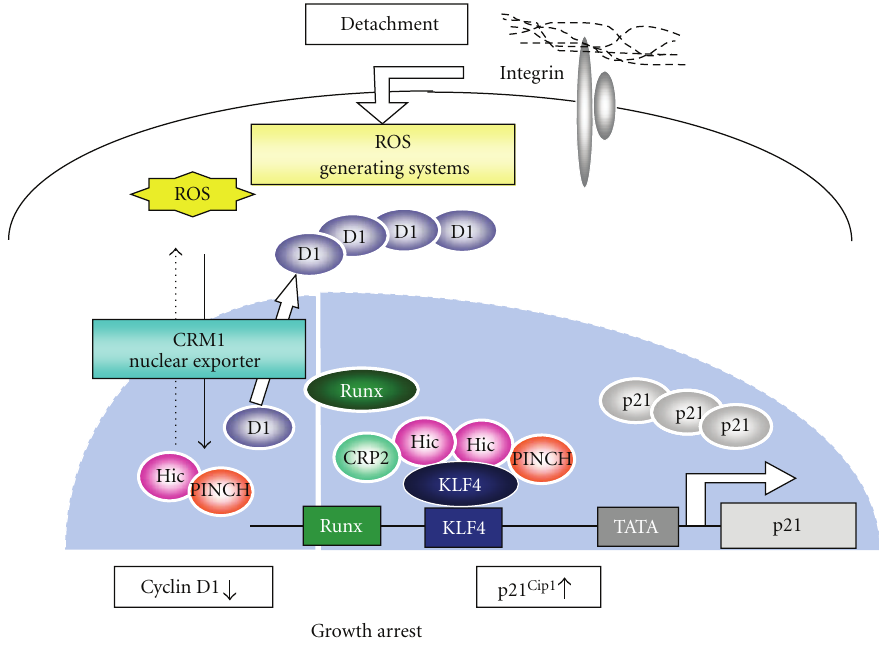
Figure 3: A fail-safe system where HIC-5 ensures the anchorage dependence of cell growth through LIM-LIM interactions. On loss of adhesion, HIC-5 activates two modes of a fail-safe system in collaboration with PINCH and CRP2 to prevent anchorage-independent cell growth. The HIC-5-PINCH unit halts its nuclear-cytoplasmic shuttling and makes way for cyclin D1 to be exported from the nucleus by CRM1, as illustrated in Figure 2, while simultaneously transactivating p21 Cip1 in the nucleus together with another HIC-5 unit, HIC-5- CRP2. As such, the dual systems, which target cyclin D1 and p21 Cip1 , respectively, cooperatively stop detached cells from proliferating and thus avoid unacceptable anchorage-independent growth (see further details in